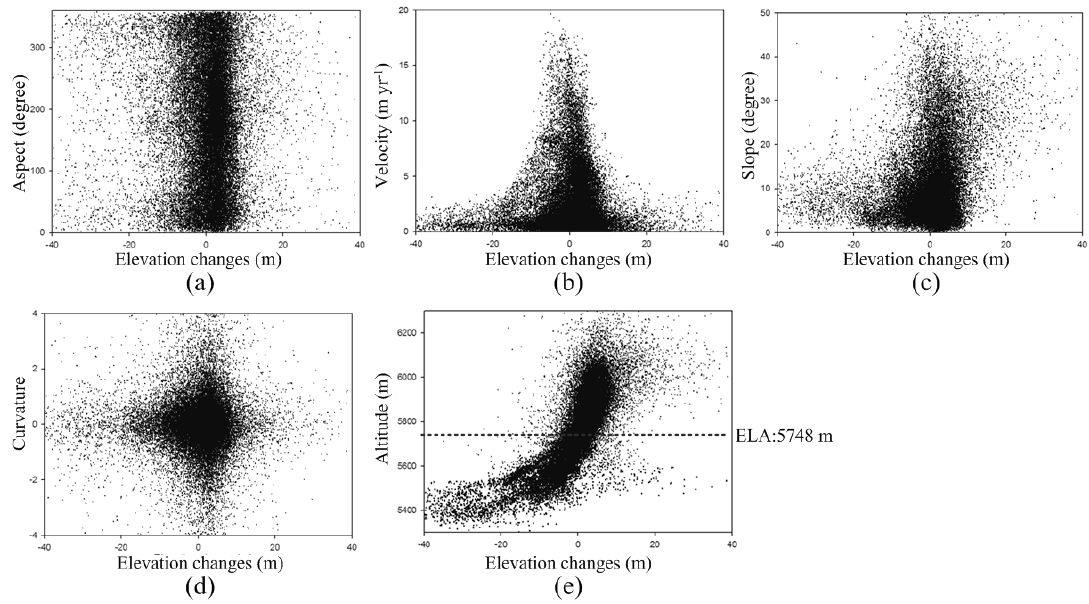
Figure 9. Correlations between glacier elevation changes and morphometric factors at local scale (grid size of 10 × 10 pixels). ( a ) aspect; ( b ) ice flow velocity; ( c ) slope; ( d ) curvature; and ( e ) altitude.